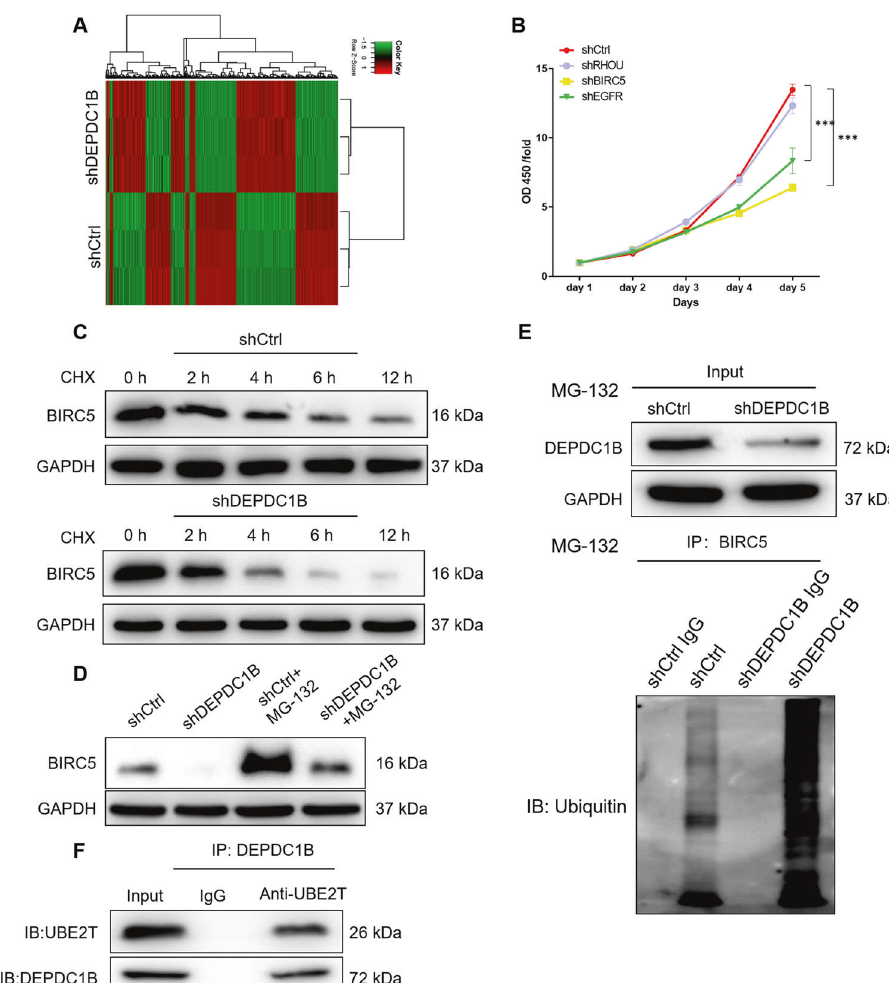
Fig. 4 DEPDC1B affects the BIRC5 ubiquitination through UBE2T in chordoma cells. A The PrimeView Human Gene Expression Array was performed to identify the differentially expressed genes (DEGs) between shDEPDC1B and shCtrl groups of MUG-Chor1 cells. B The effects of knockdown of RHOU, BIRC5, and EGFR on proliferation of MuG-Chor1 cells were examined. C Protein levels of BIRC5 in MUG-Chor1 cells with or without DEPDC1B knockdown following 0.2 mg/mL CHX treatment for 0 – 12 h. D Levels of BIRC5 proteins in MUG-Chor1 cells with or without DEPDC1B knockdown following MG-132 treatment for indicated times (12 h). E The lysates of MUG-Chor1 cells were immunoprecipitated and WB was performed to examine the ubiquitination of BIRC5. F Co-IP analysis of interaction of DEPDC1B and UBE2T in MUG-Chor1 cells. The presented results were representative of experiments repeated at least three times. Data were represented as mean ± SD. *** P <